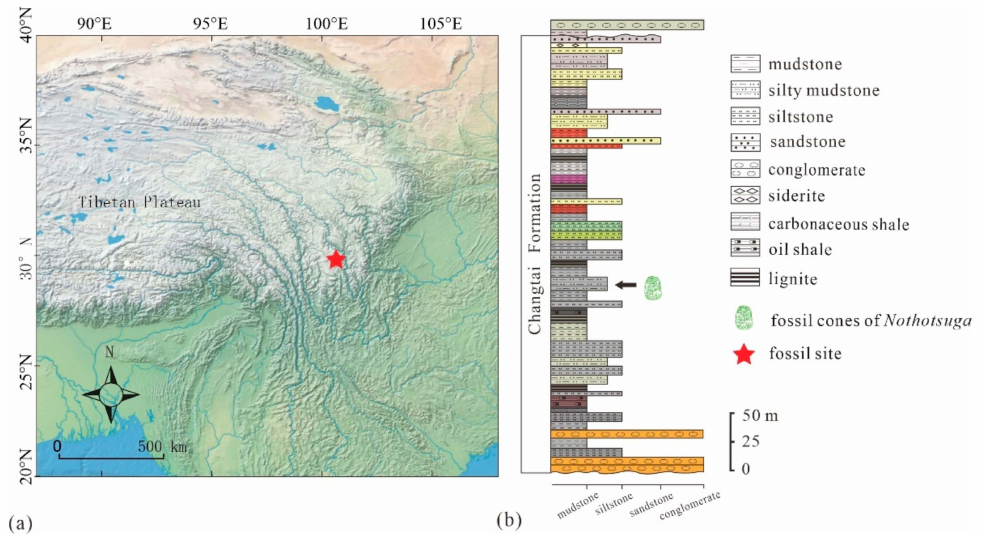
Figure 1. ( a ) The location of fossil site in Xiamula village, Litang County, western Sichuan Province. ( b ) Stratigraphic sequence of the Miocene Changtai